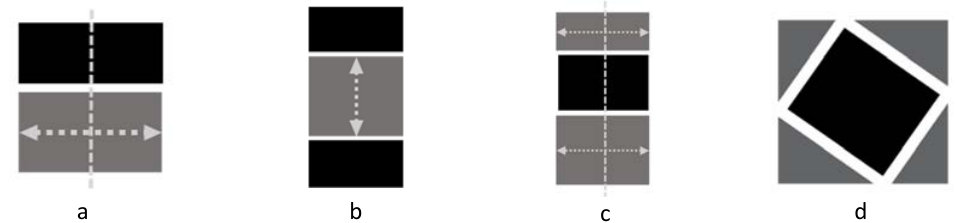
b a d c Fig. 10: Evolution of open space, a- Open space in Umayyad and Mamluk mosques, b- Open space in Ayyubid mosques, c- Open space in Fig. 10: Evolution of open space, a‐ Open space in Umayyad and Mamluk mosques, b‐ Open space in Ottoman mosques, d- Open space in contemporary mosque Ayyubid mosques, c‐ Open space in Ottoman mosques, d‐ Open space in contemporary mosque